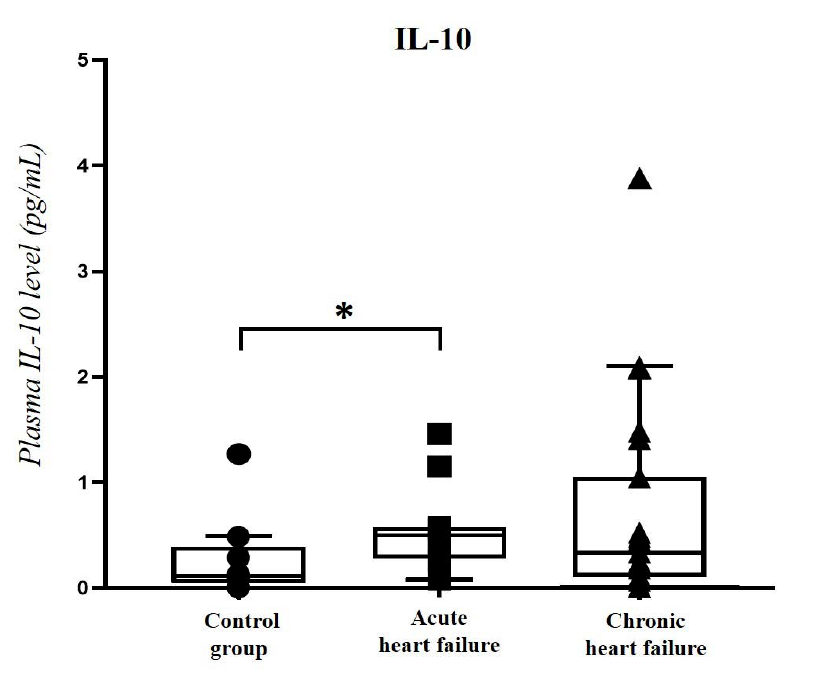
Figure 5. IL-10 levels in acute ( n = 12) and chronic heart failure ( n = 19) patients and in the control group ( n = 9). The box plot diagram represents the interquartile range, median values and the outliers. The individual values are presented with black dots (control group), squares (acute HF) or triangles (chronic HF). Statistical analysis was performed with one-way ANOVA test with Tukey post-hoc test. * p < 0.05 vs. control group.